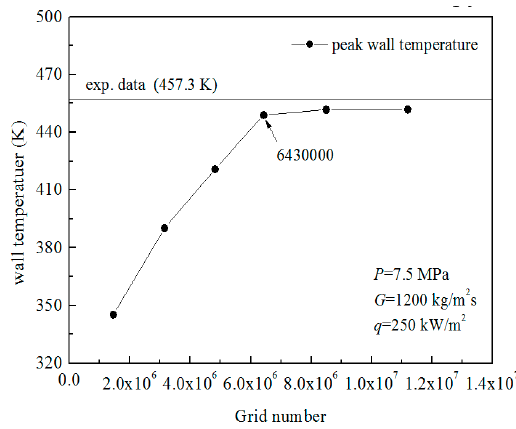
Figure 14. Validation of the grid dependence.